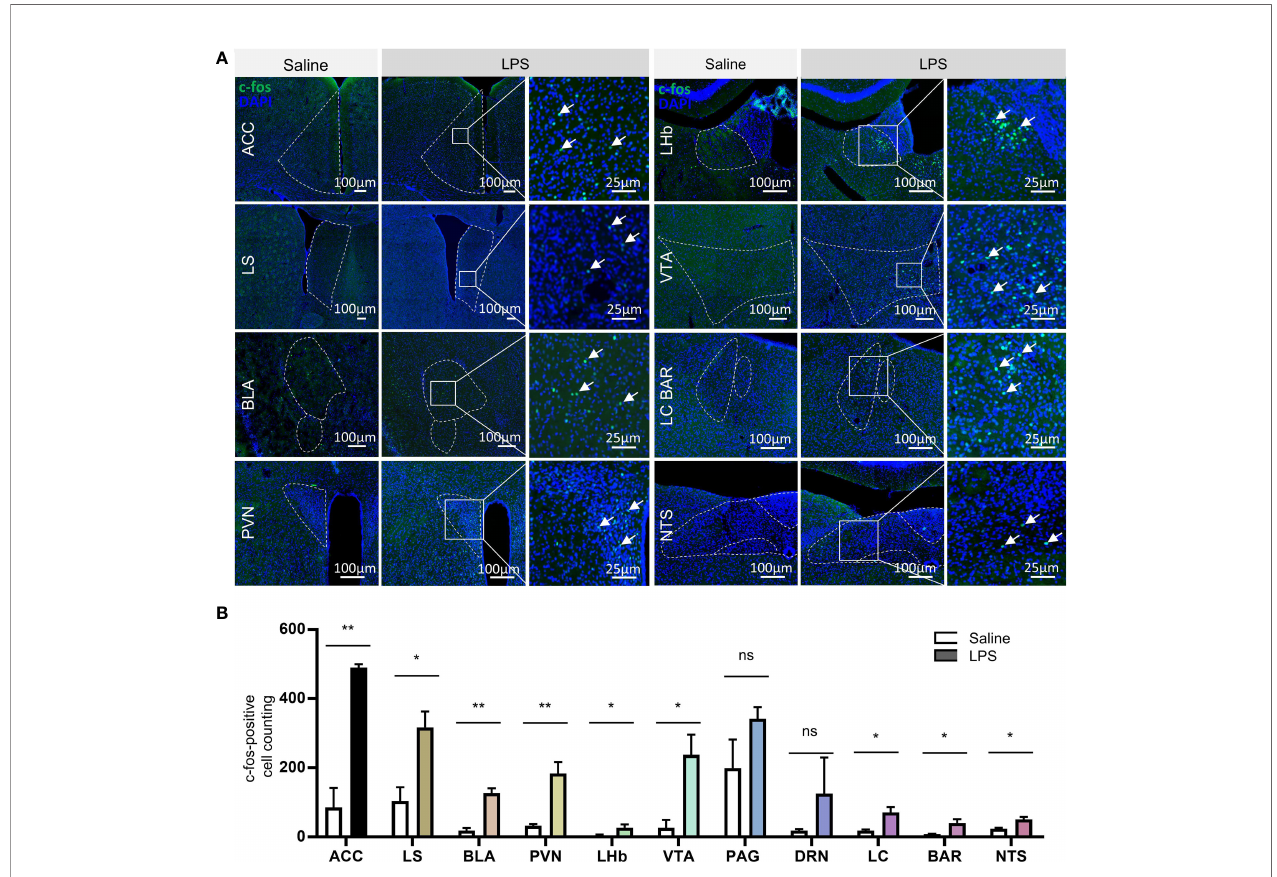
FIGURE 5 | LPS treatment caused broad brain nuclei activation related to stress response. (A) Representative images of c-fos immunostaining in brain nuclei, including the anterior cingulate cortex (ACC), lateral septum (LS), basolateral amygdala (BLA), paraventricular nucleus of the hypothalamus (PVN), lateral habenular nucleus (LHb), ventral tegmental area (VTA), locus coeruleus (LC), Barrington ’ s nucleus (BAR), and nucleus of the solitary tract (NTS) (green, c-fos; blue, DAPI; scale bars = 100 and 25 m m). (B) Quantitative analysis of the c-fos-positive neurons in the above brain nuclei showed signi fi cant increase in neural activation in nuclei including ACC, LS, BLA, PVN, LHb, VTA, LC, BAR, and NTS, which are all stress response nuclei (data are presented as mean ± SEM, Student ’ s t-test, n = 3-4 for saline, n = 3 – 4 for LPS, **p < 0.01; *p < 0.05 ns, p >